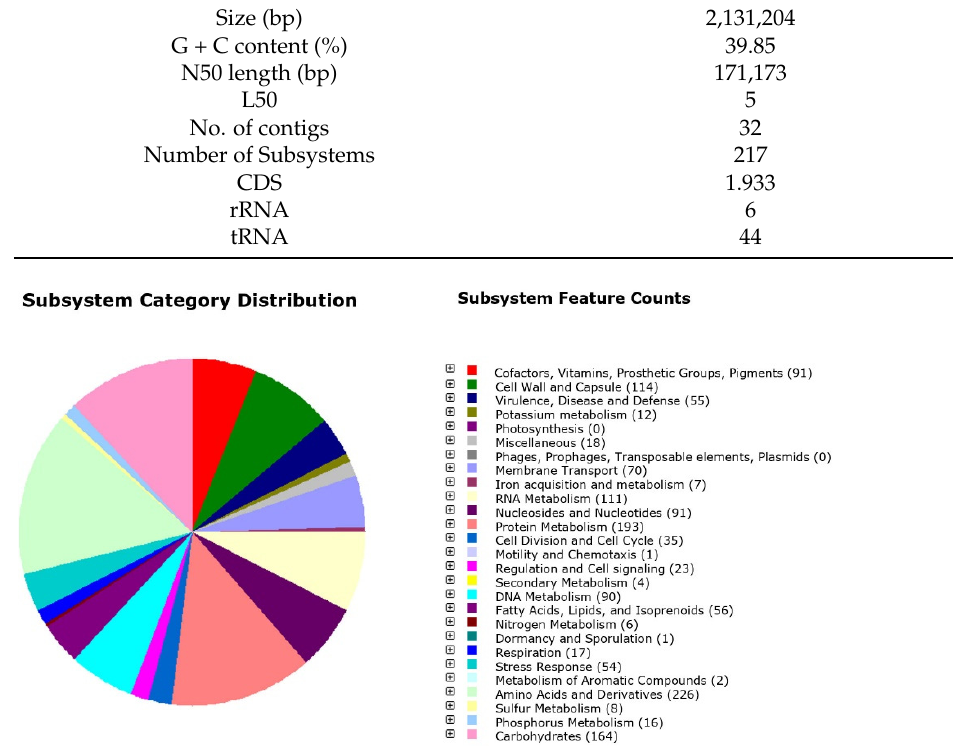
Figure 1. Subsystem category distribution of Streptococcus salivarius 24SMBc revealed by genome annotations based on the RAST server. Each color represents a subsystem category with the feature counts listed on the right.